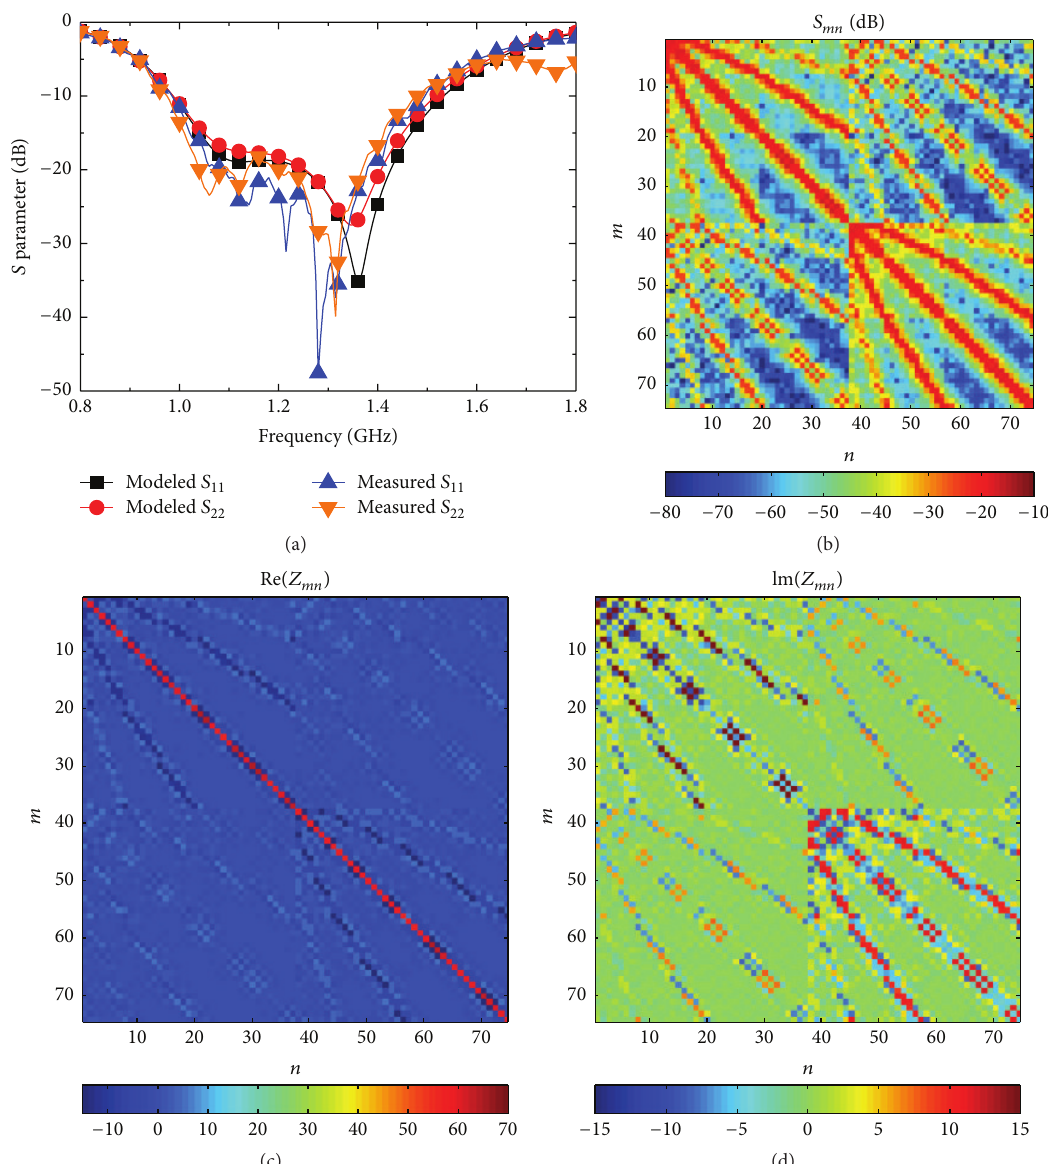
Figure 9: Scattering and impedance characteristic. (a) Modeled and measured reflection coefficients of the antenna. (b) Scattering matrix of the array. (c) Real part of the impedance matrix. (d) Imaginary part of the impedance